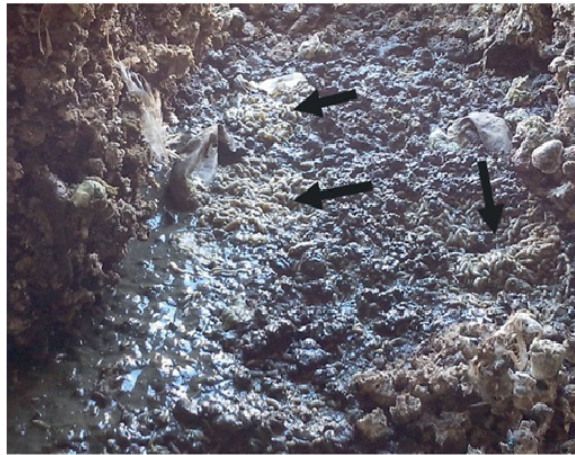
Figure 1. Poultry houses containing manure with excess moisture and presence of diptera larvae (indicated by the